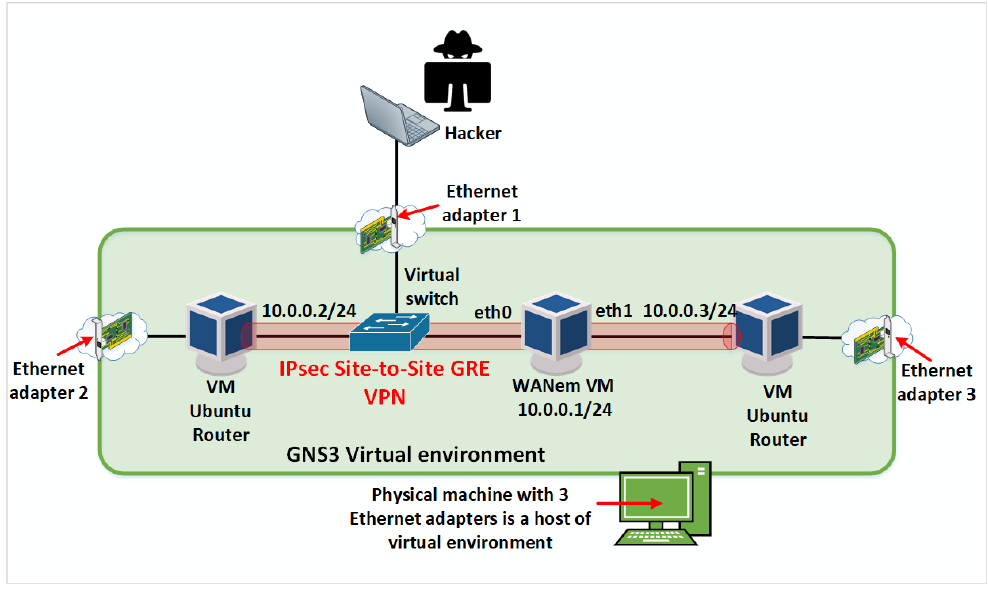
Figure 6. Traffic sniffing. Figure 6. Tra ffi c sni ffi